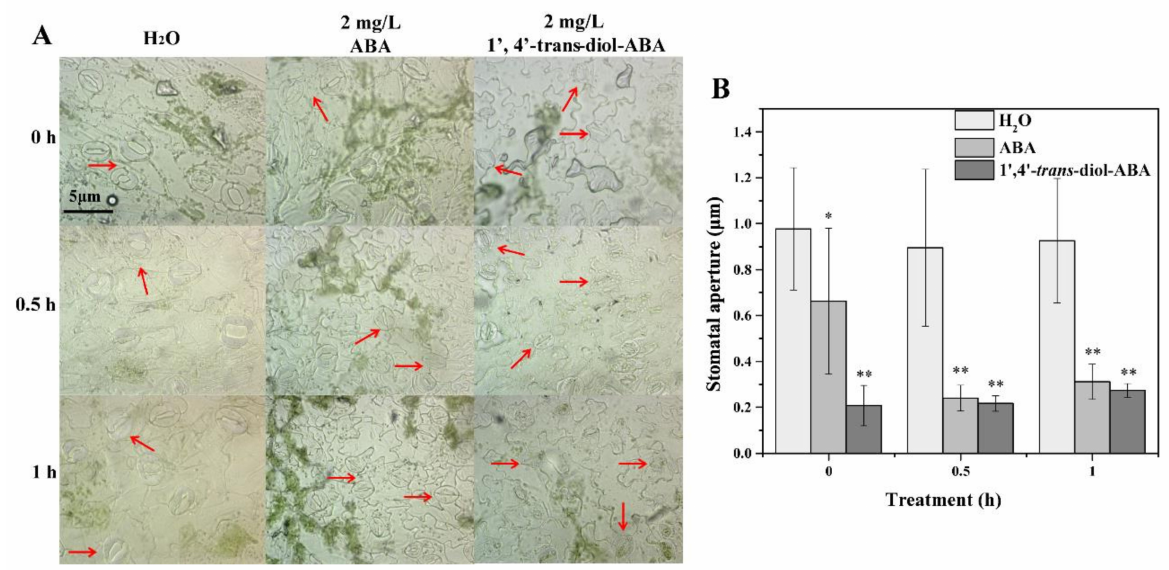
Figure 2. The effect on the stomatal opening of tobacco leaves by soaking with 1 (cid:48) ,4 (cid:48) - trans -diol-ABA. ( A ) The stomata forms of the leaves in lower epidermis under the microscope observed. The magnification is 400 × . Scale bar, 5 µ m. The red arrows point stomata: In control group, most stomata are open; In treatment groups, most are closed. ( B ) Stomatal opening states under different treatments. The aperture 40 stomata per experiment are measured and counted. Asterisks (*) indicate significant difference from the control (H 2 O) at * p < 0.01 or ** p <